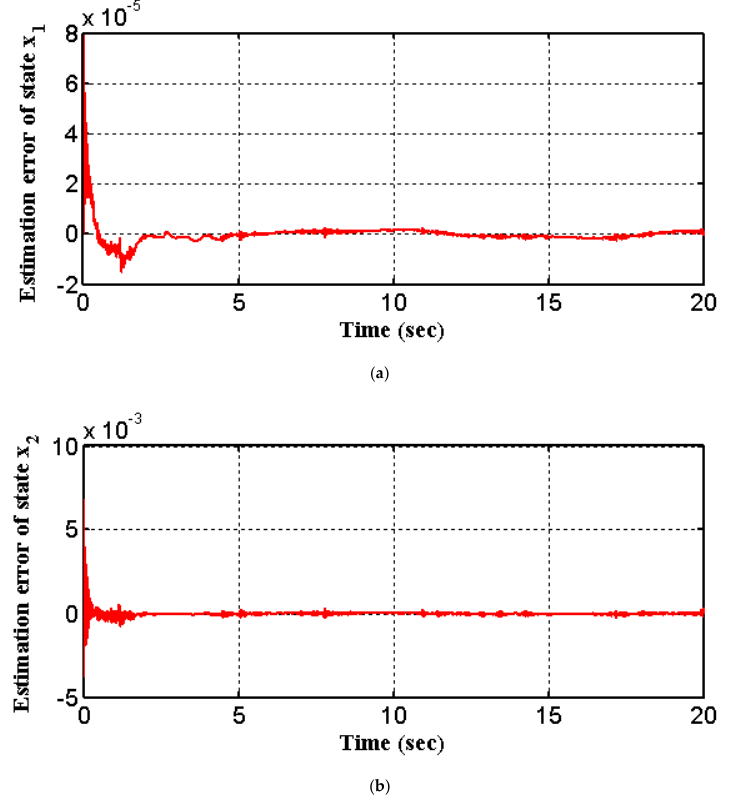
Figure 10. Estimation errors with measurement noise using C-ADRC, ( a ) e 1 ( b ) e 2 .